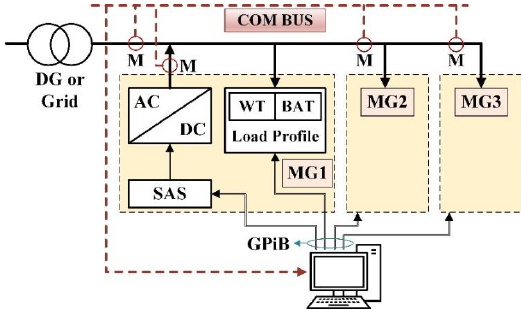
Figure 8. Implemented structure of the NHMG.